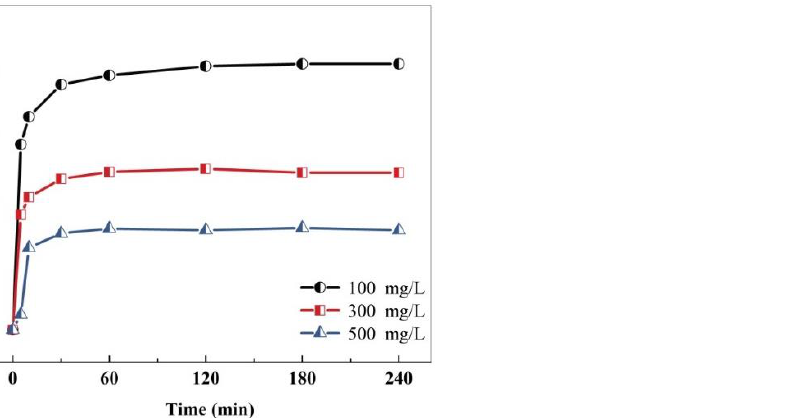
Figure 5. Effect of initial humic acid (HA) concentration on the adsorption of HA onto RGO-SiO 2.